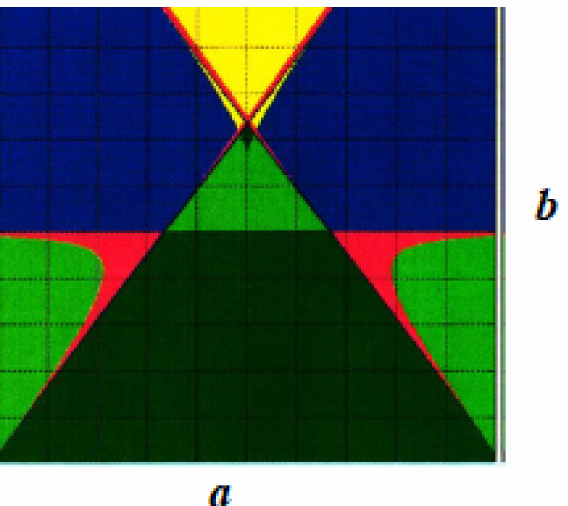
Figure 4. Bifurcation diagram of the Brusselator MCNN model (2). The color indicates locally active and stable region (edge of chaos)—red, locally active and unstable region—green, locally passive region—blue , no equilibrium point is both locally active and